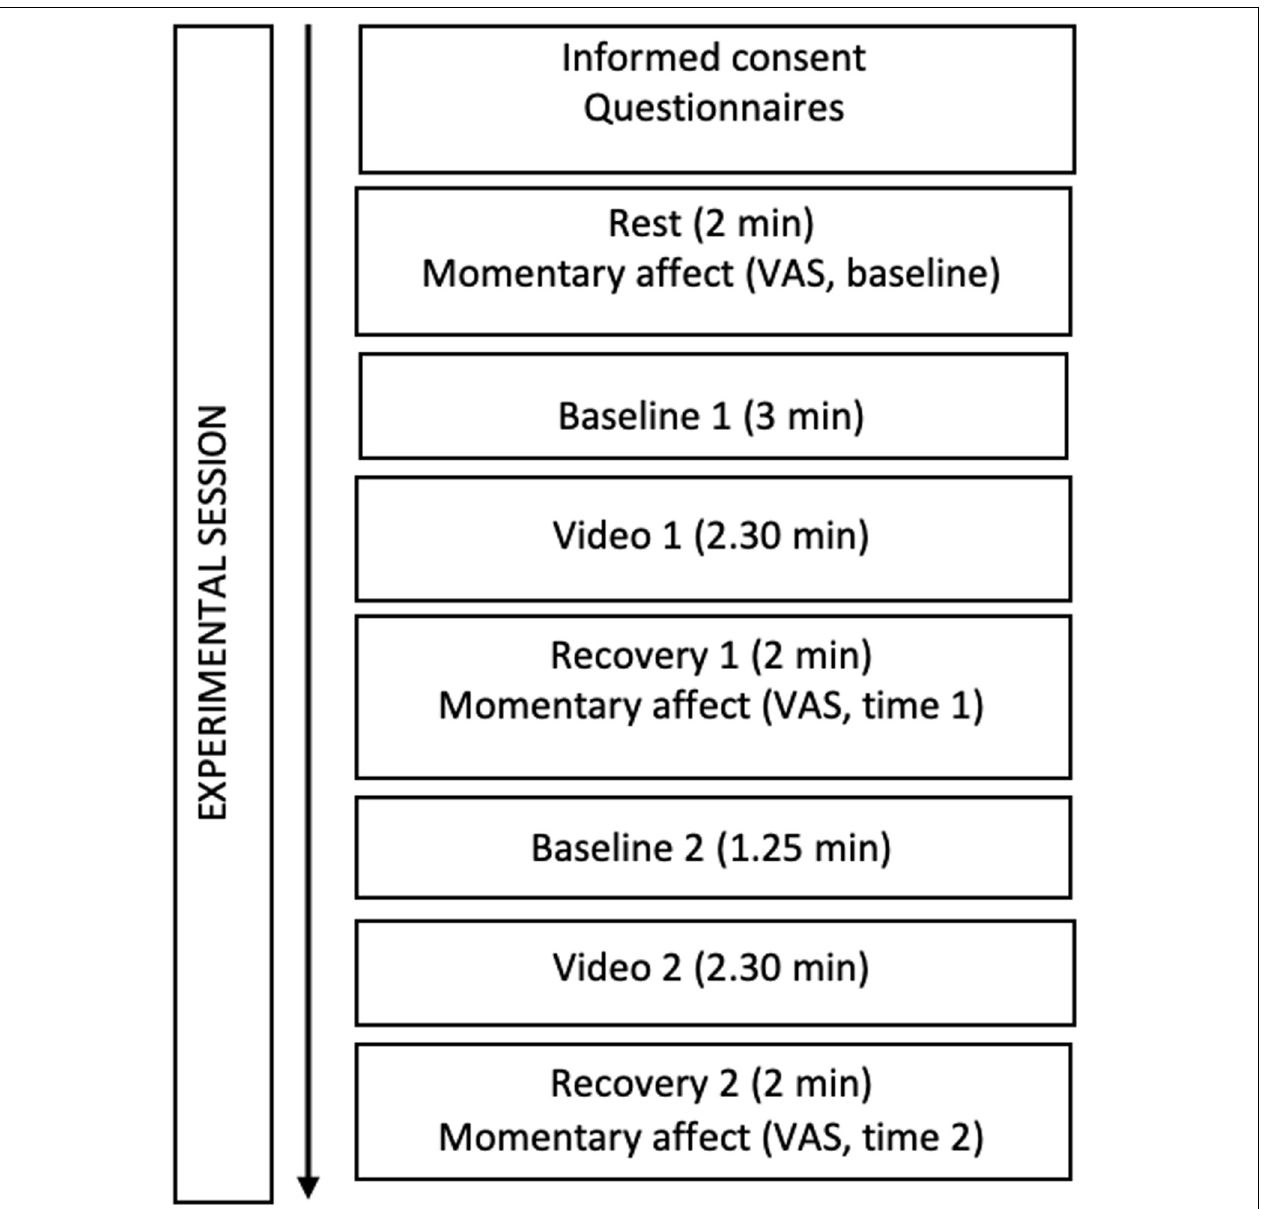
FIGURE 1 | Flowchart illustrating the experimental